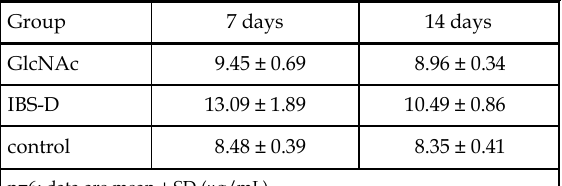
Table II: Serum DAO activity after GlcNAc